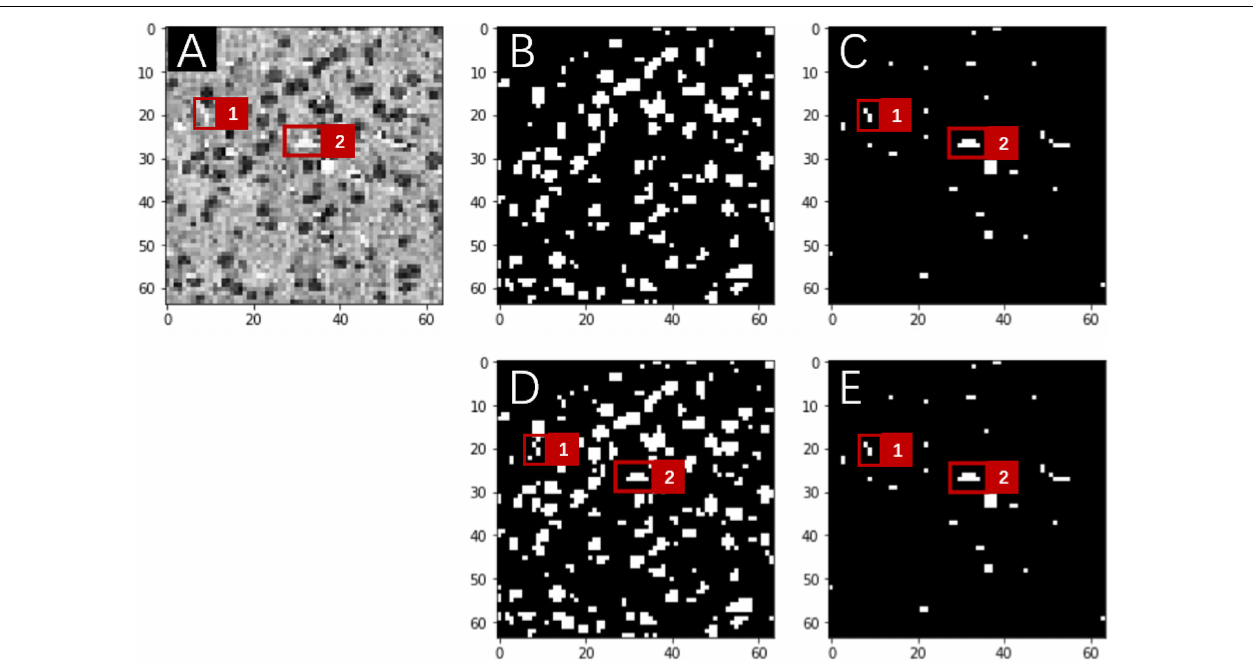
FIGURE 3 | Network predictions vs. human annotations for a MOST 2D image (downsampling to 64 × 64 pixels) using the multilabel U-Net architecture with the standard cross-entropy loss function in a preliminary study. These preliminary studies were implemented with reduced image resolutions from the original MOST dataset for the purpose of fast explorations of parameter space. A frame from the raw image (A) contains somata (dark gray) and vessels (white), which are labeled in panels (B,C) and were predicted by the network in panels (D,E) , respectively. Red squares numbered 1 and 2 in panel (A) mark two vessel structures, which are annotated in panel (C) and were correctly predicted by the network in the “vessel” output layer [as in panel (E) ] but mistakenly predicted in the “somata” output layer [as in panel (D)